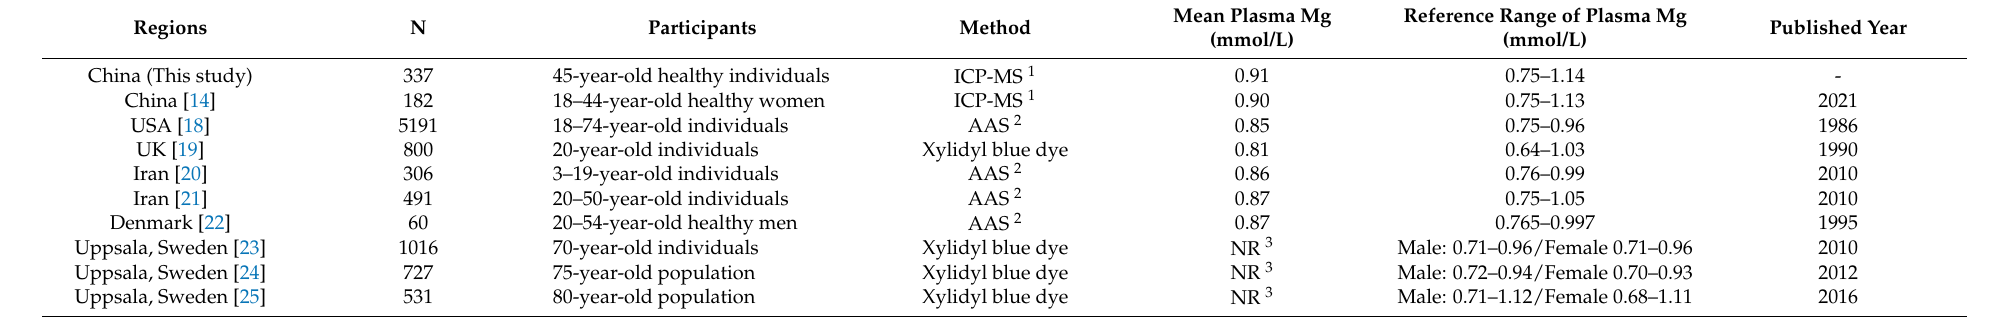
Table 3. The reference ranges of plasma Magnesium in different